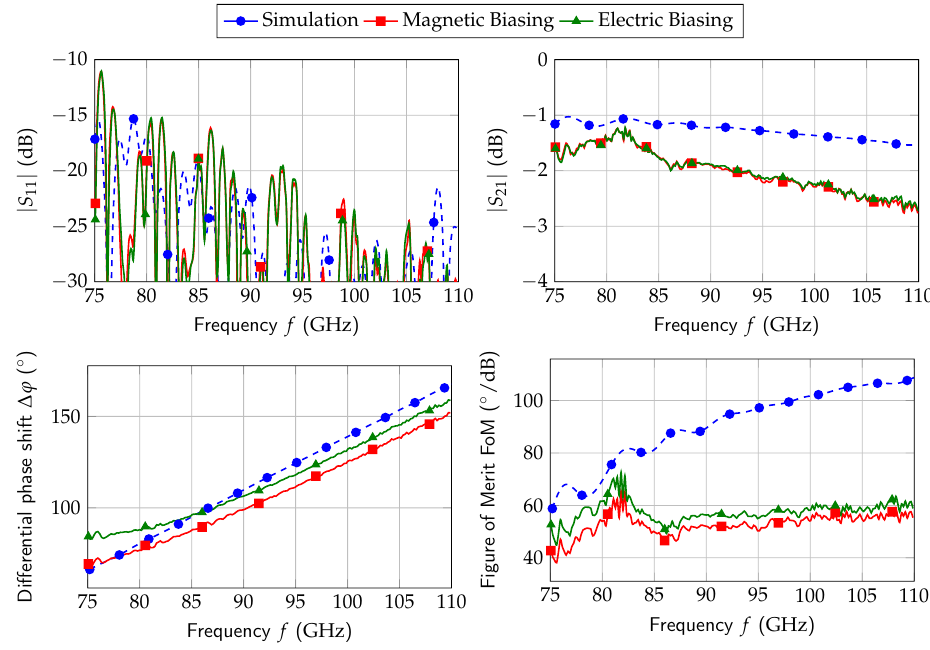
Figure 28. Measured (solid) and simulated (dashed) results of the subwavelength fiber phase shifter. For simplification, s-parameter plots show perpendicular orientation only.